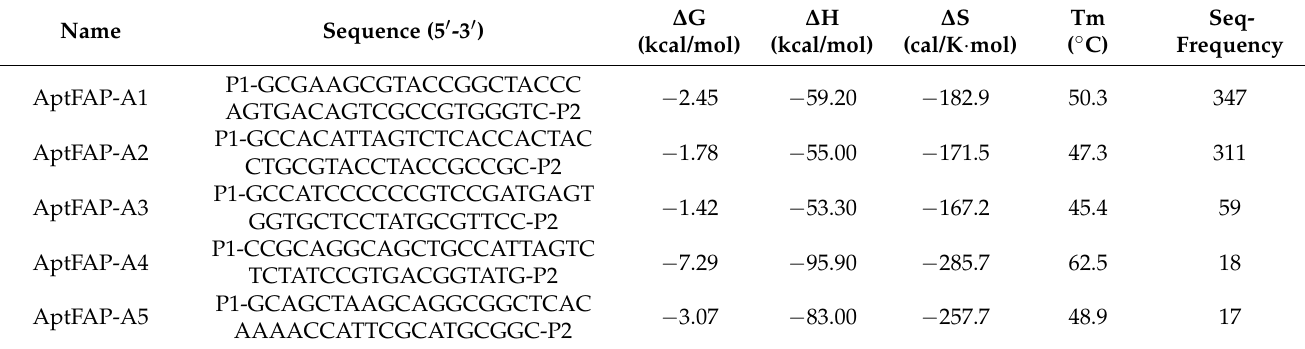
Table 1. Sequences and thermodynamic parameters of five candidate aptamers.